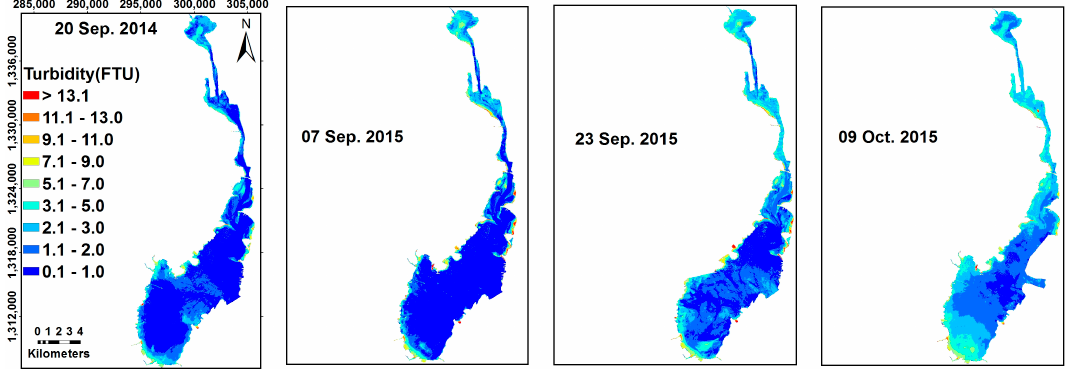
Figure 7. Turbidity distributions in rainy season (cloud cover areas masked).